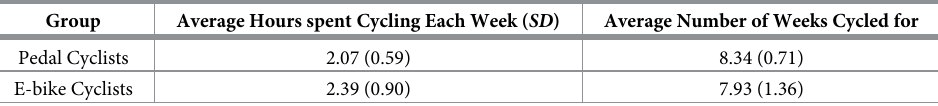
Table 3. Average weekly (standard deviation) cycling durations for the pedal and e-bike cyclists. Group